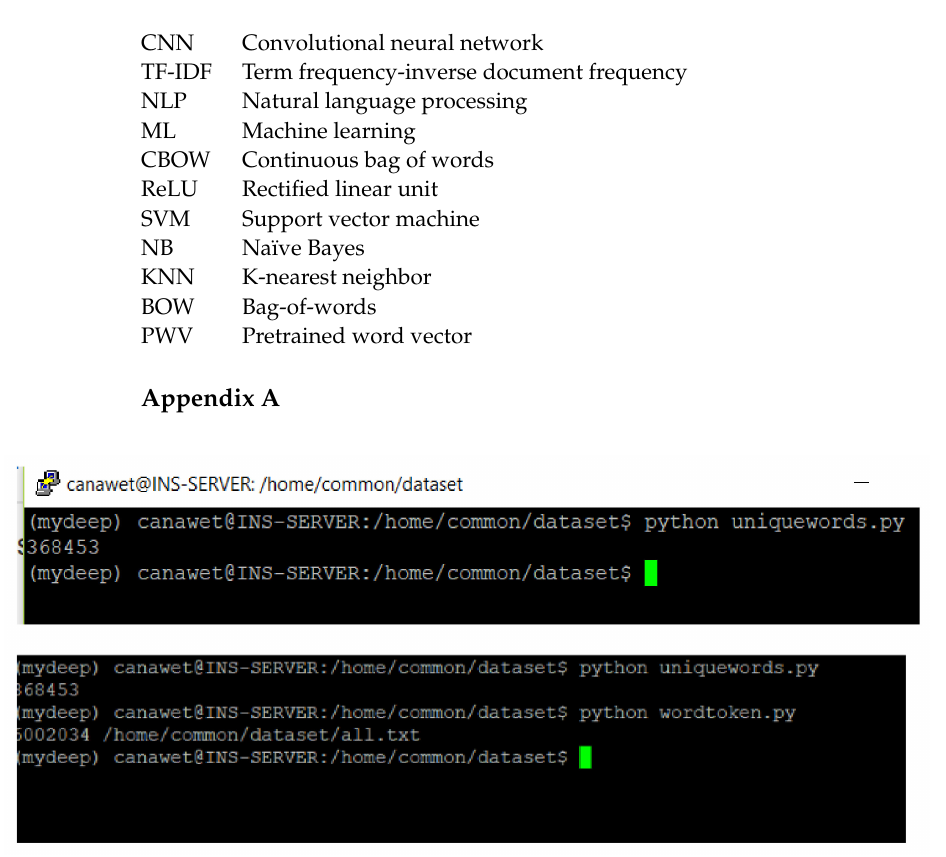
Figure A1. Further